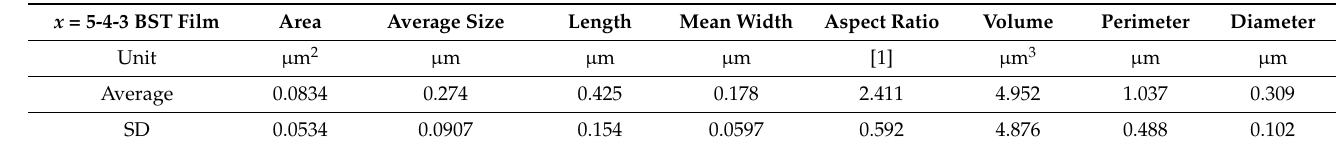
Table 5. Parameters of the grain analysis of the “upgraded” ( x = 5-4-3) BST thin films deposited on stainless-steel substrates.